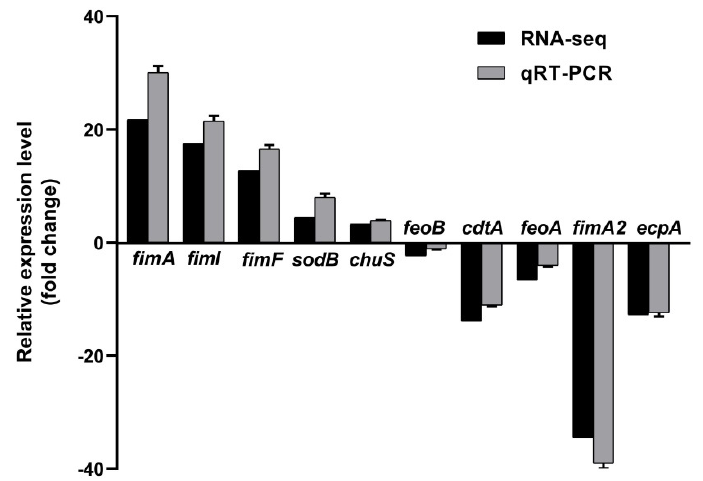
Figure 4. Verification of randomly selected differential expression of genes (DEGs) screened from RNA-seq data by qRT-PCR.